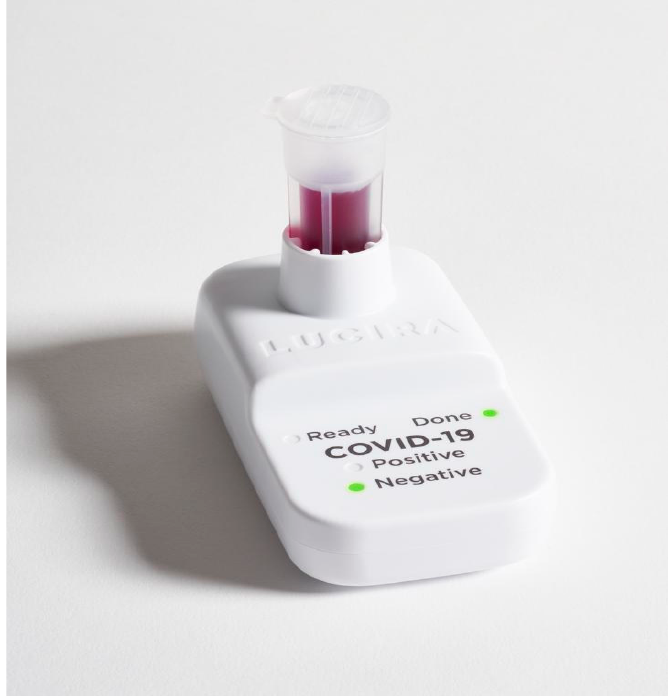
Figure 1. Lucira™ Check It COVID-19 Test kit.